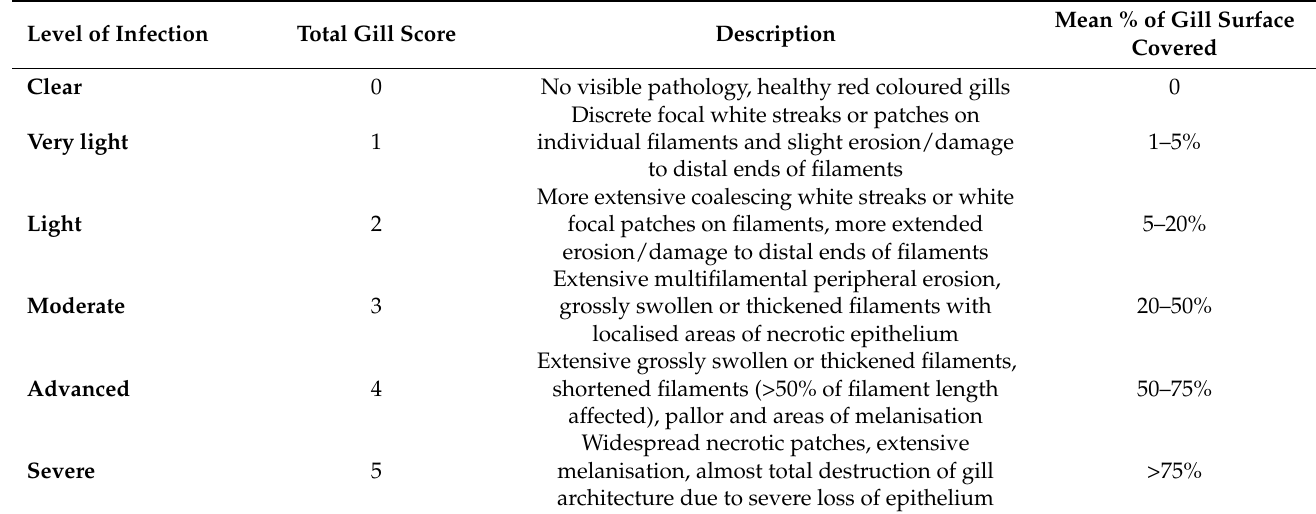
Table 1. Total gill scoring system to estimate severity of multifactorial gill disease in Atlantic salmon ( Salmo salar ). Level of Infection Total Gill